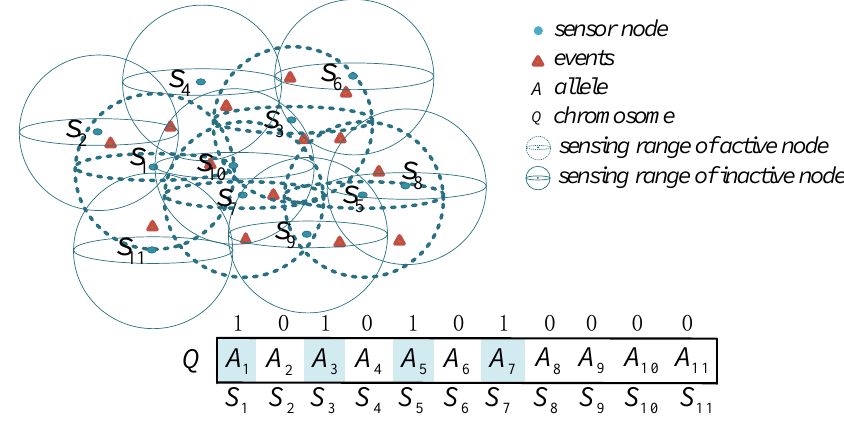
Figure 2. Coding rule